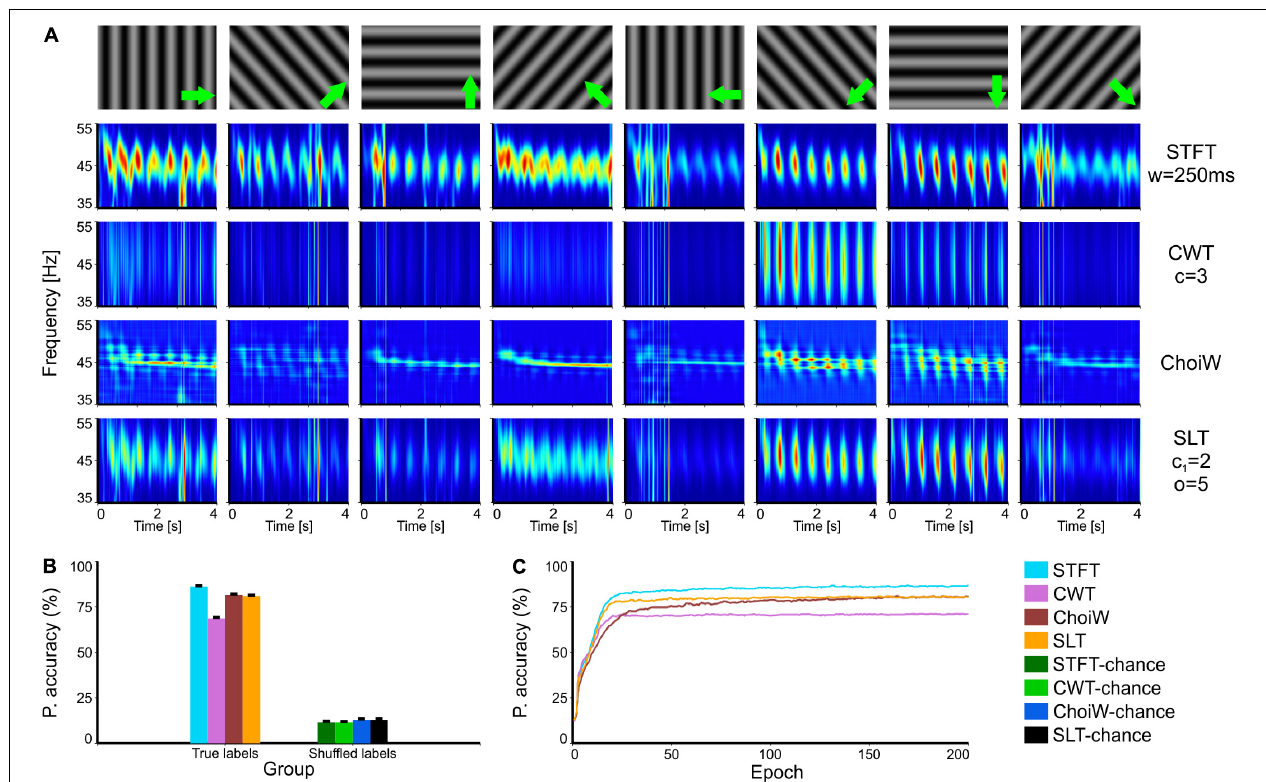
FIGURE 4 | Intracranial electrophysiology with SRCS visual stimulation protocol (SRCS-2). (A) Table of TFRs where each column corresponds to a particular grating direction (condition) and each row corresponds to one of the time-frequency analysis methods. (B) Average accuracy as measured on the validation set (100 network initializations and dataset splits), with original (true) and shuffled labels (for chance level estimation). (C) Learning curves on the validation set for the original labels group (chance level curves were omitted here but reside at ∼ 12.5%). Error bars are